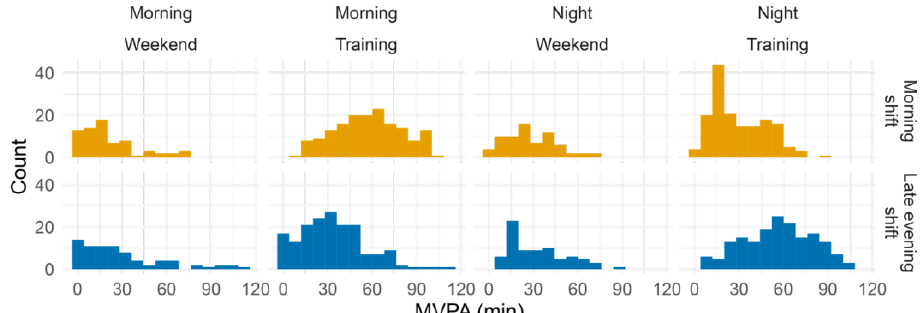
Figure A1. Moderate-to-vigorous activity distribution. Histograms showing the minutes of moderate-to-vigorous physical activity distribution ( n = 31; 461 observations in the morning window and